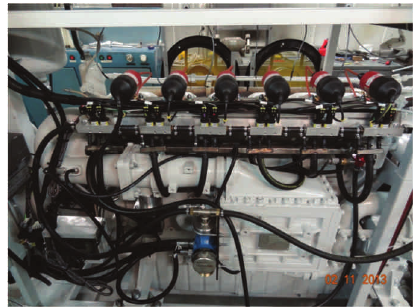
Fig. 2. Ignition system and post-process gas fuel supply system of 6-cylinder engine